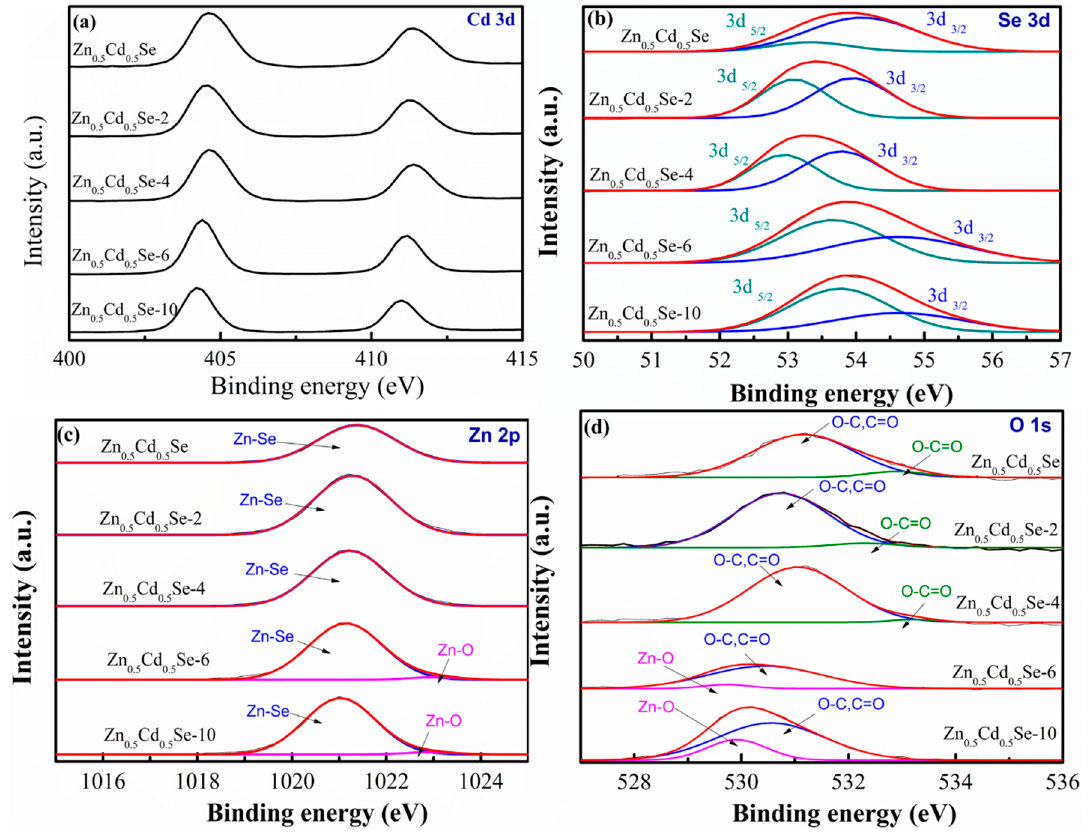
Figure 6. ( a ) Cd 3d, ( b ) Se 3d, ( c ) Zn 2p, and ( d ) O 1s X-ray photoelectron spectroscopy (XPS) spectra showing the influence of the various OLA content on Zn 0.5 Cd 0.5 Se and Zn 0.5 Cd 0.5 Se-y.